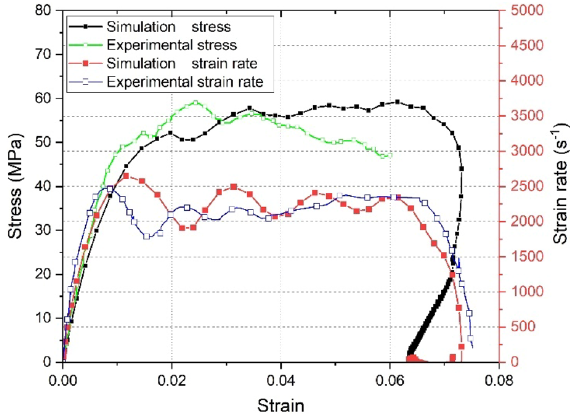
Figure 9. The comparison of stress–strain and strain rate curves changes during the simulation.